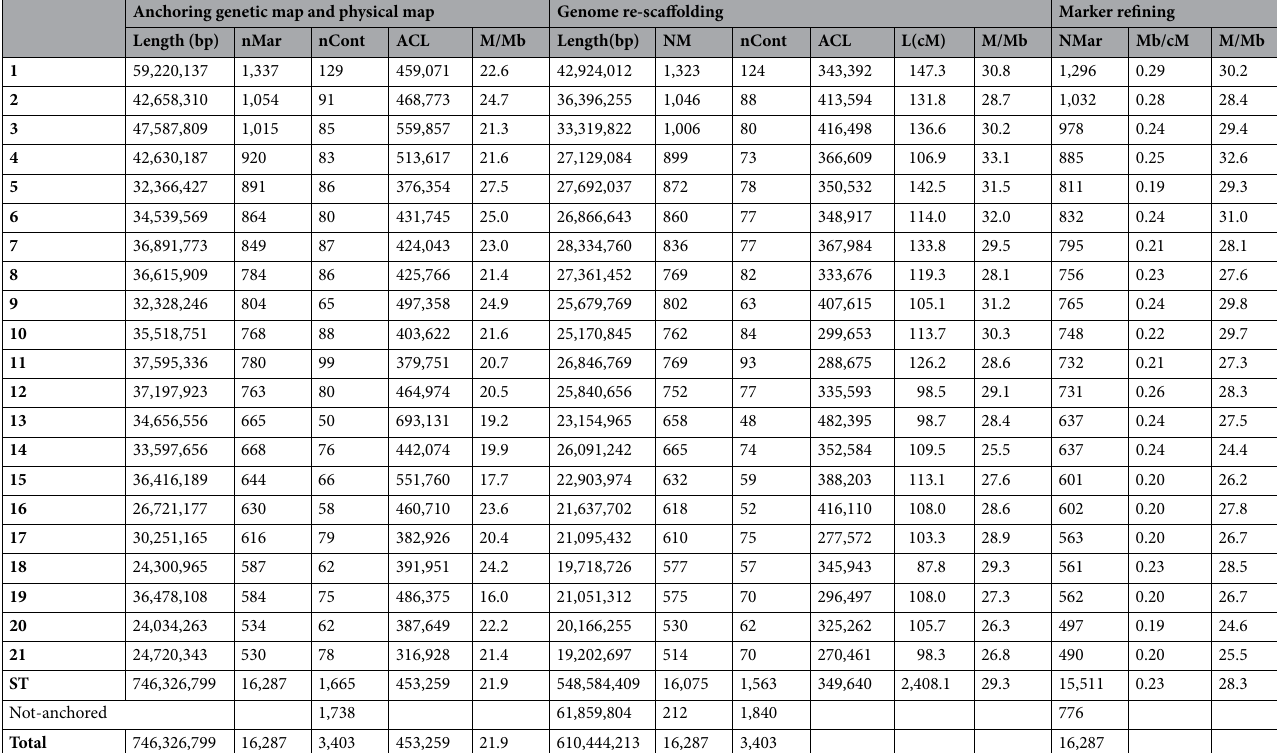
Table 4. Information for anchored physical map (LepMap3 step), after genome re-scaffolding (Lep-anchor3 step) and after removal of markers with discrepancies between genetic and physical maps (MareyMap step). The physical (bp) and genetic (cM) length of each linkage group, number of markers (nMar), number of contigs (nCon), average contig length (ACL), marker density density (markers per megabase; M/Mb) and the ratio physical to genetic length (Mb/cM) for sex-average genetic-physical map are